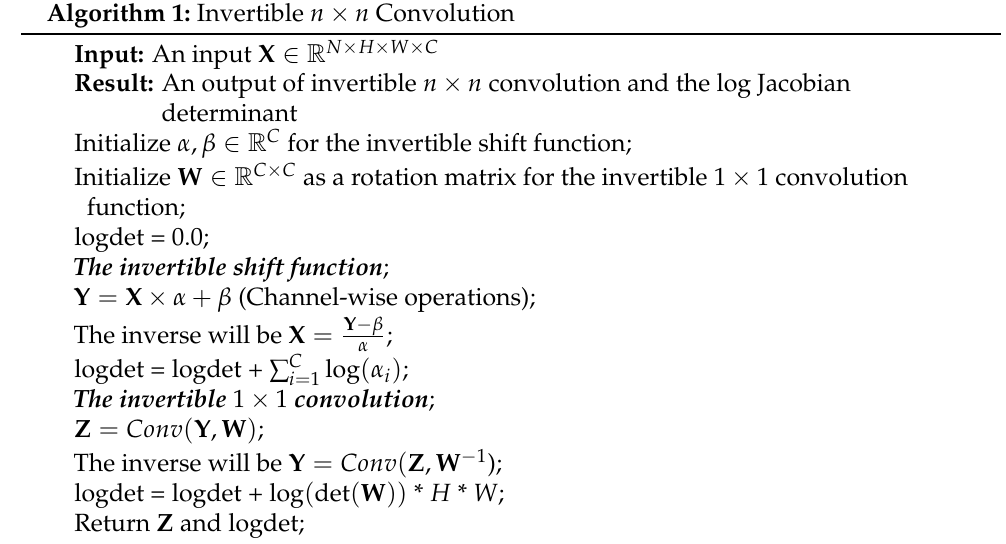
Algorithm 1: Invertible n × n Convolution